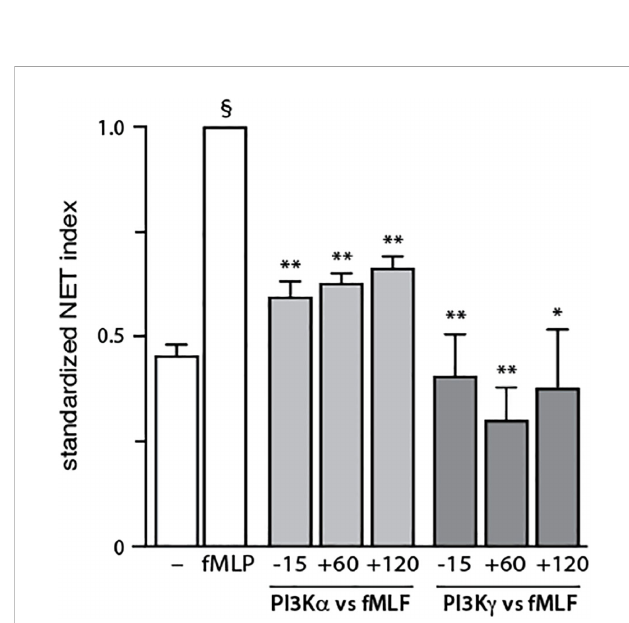
FIGURE 2 Belated inhibitory effect of PI3K isoforms on NET formation. Neutrophils cultured at 37°C on poly-L-lysine-coated coverslips were exposed to 1 m M PI3K a inhibitor IV (PI3K a -selective) or 1 m M AS64002 (PI3K g -selective), either before (-15 min) or into (+60 or +120 min) a 4-h stimulation with 100 nM fMLF. NET formation was assessed using PlaNET Green as described in Methods . Mean ± s.e.m. of the standardized NET index from 3 independent experiments. *, p<0.05; **, p<0.01 vs stimulus alone. §, p < 0.001 for unstimulated cells vs